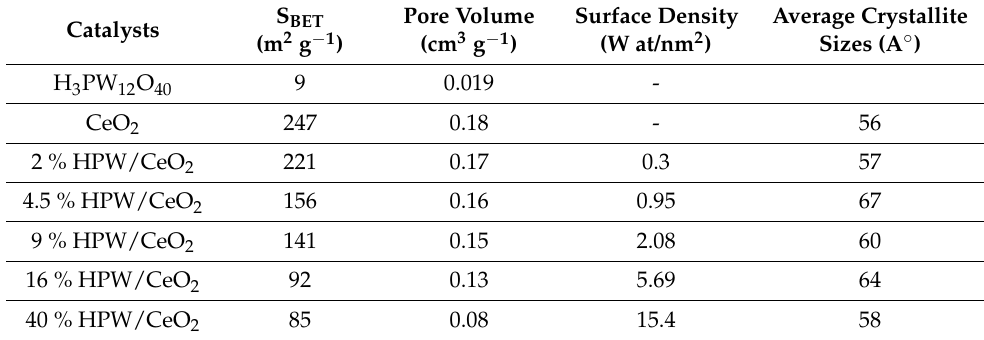
Table 1. Textural properties of CeO 2 , H 3 PW 12 O 40, and HPW/CeO 2 (2, 4.5, 9, 16, and 40 wt% W). Catalysts